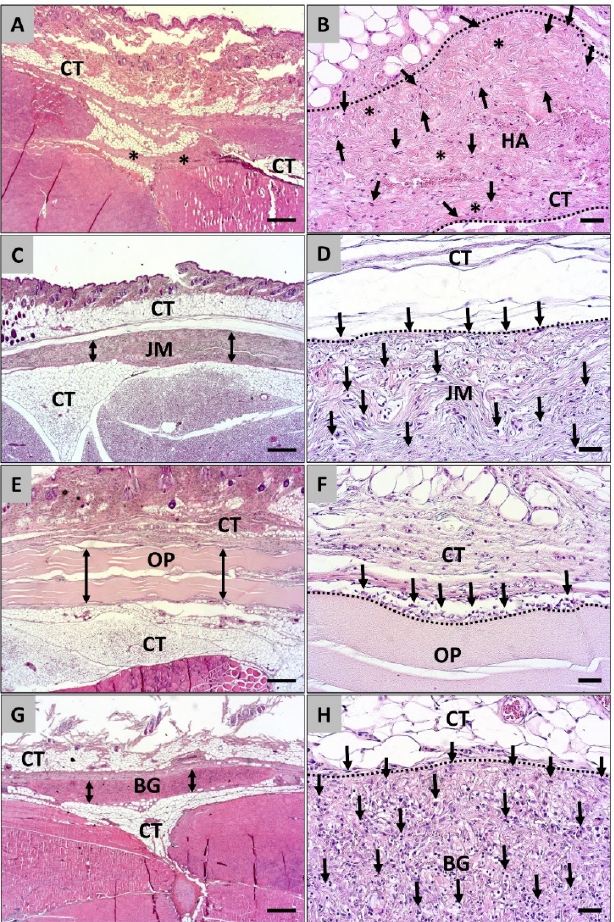
Figure 4. Histological images of the integration behavior and the tissue reactions of the four different collagen membranes implanted into the subcutaneous connective tissue (CT) at day 60 post implan ‐ tationem . Left column: Only some remnants (asterisks) of the hyaluronan/collagen membrane (as ‐ terisks in A ) were found at this late time point, while the other membranes ( C , E , G = double arrows) were detectable within their implantation beds without signs of fragmentation or material break ‐ down (H&E staining, 100× magnification, scalebar = 200 μ m). Right column ( B , D , F , H ): Different cellular migration patterns (black arrows) were observed starting from the material surfaces (dashed lines). HA = hyaluronan/collagen membrane, JM = Jason ® membrane, OP = Ossix ® Plus membrane, BG = Bio ‐ Gide ® membrane (H&E staining, 200× magnification, scalebar = 20 μ m). Table 1. Results of the cellular penetration in the four different study groups (mean values ± standard deviation). Coll ‐ HA Membrane Jason ® Membrane Ossix ® Plus Membrane BioGide ® Membrane